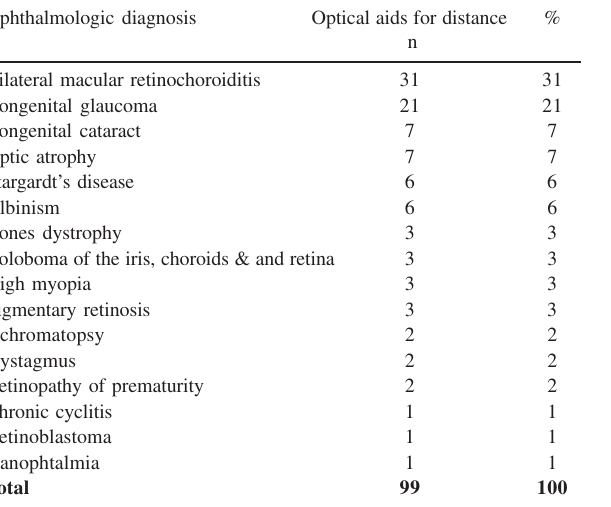
Pigmentary retinosis